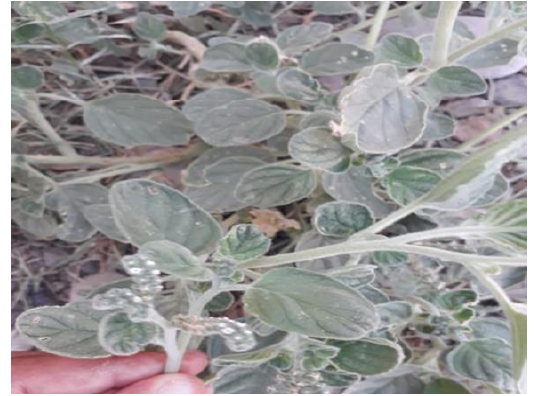
Figure 1. The Iraqi Heliotropium europaeum Materials and